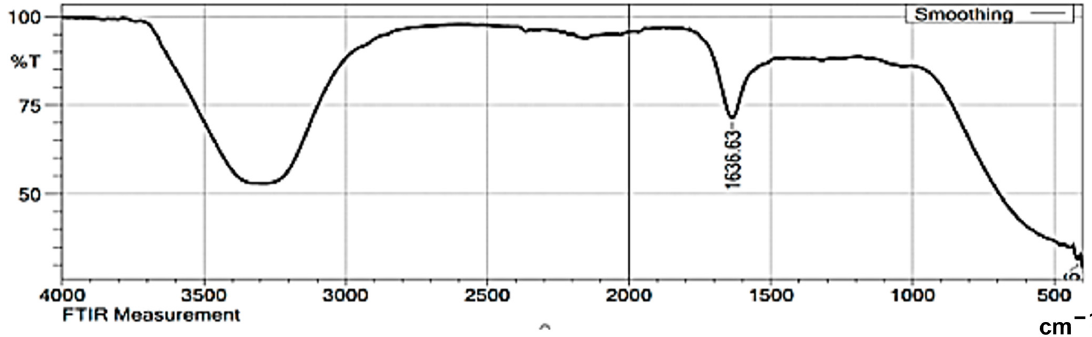
Figure 2. FTIR spectroscopy for the synthesized silver nanoparticles.